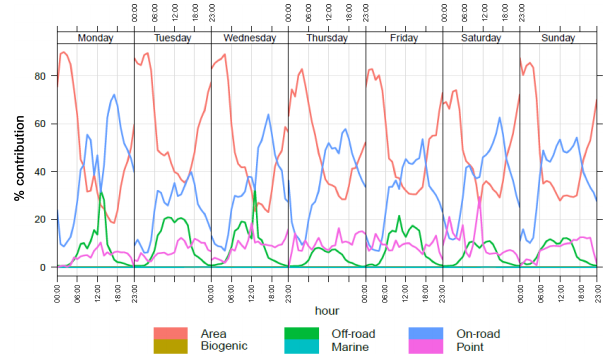
Figure 7. Modelled sectoral percent contributions to diurnal local CO 2 enhancement for February 2016 at Downsview averaged by day of week. Note: area = area + residential natural-gas combus- tion + commercial natural-gas combustion. (Time zone is